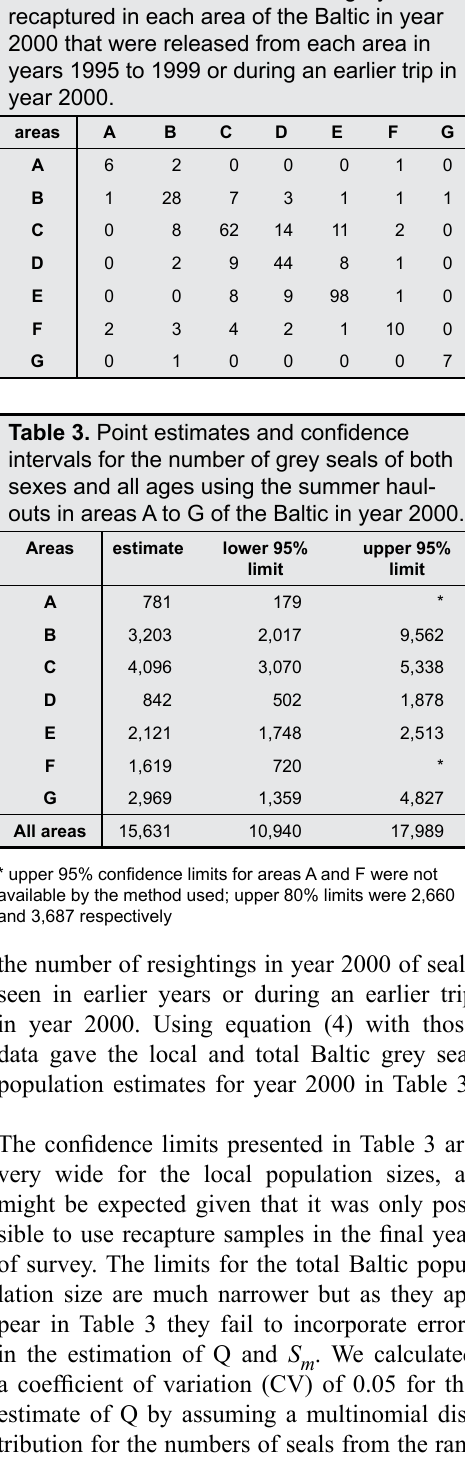
the CV of 0.115 corresponding to the confidence limits in table 3 increases the CV for the